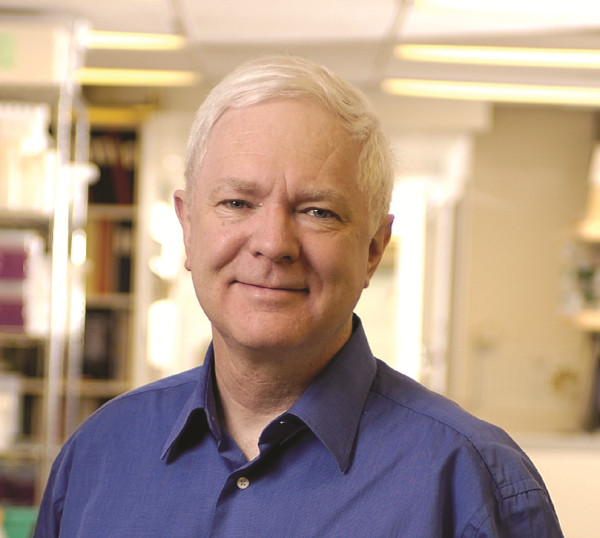
Anthony J Pawson